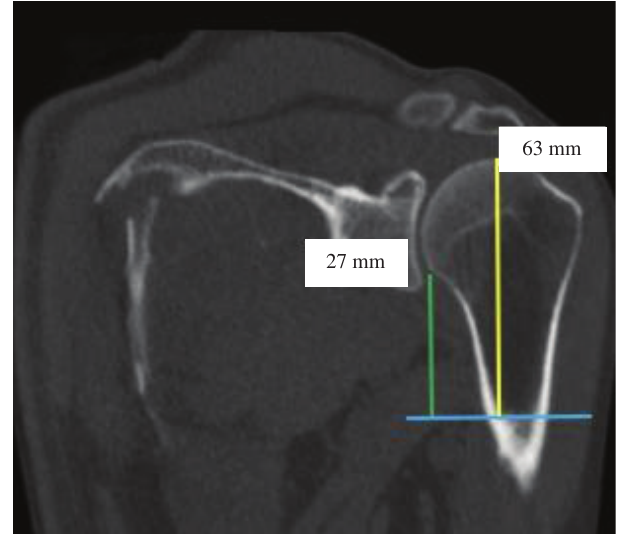
Figure 14. PM-humeral head distance (yellow) was two times greater than PM-anatomical neck distance (green) (ratio = 0.5).